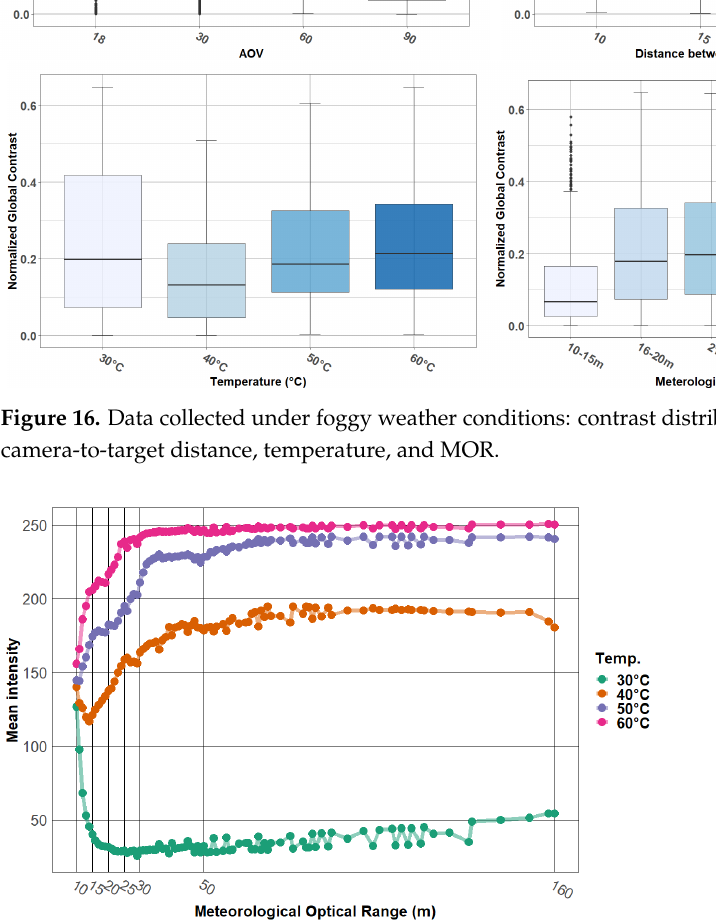
Figure 17. Discretization of the variable MOR into different-sized